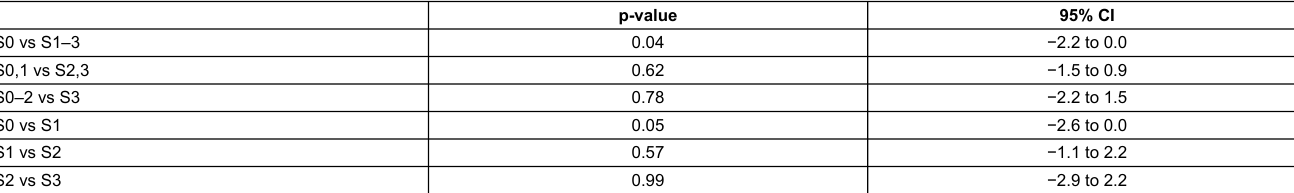
Table S2: The p-values and 95% confidence intervals (CI) from Mann-Whitney U-tests comparing liver stiffness between steatosis grade groups.